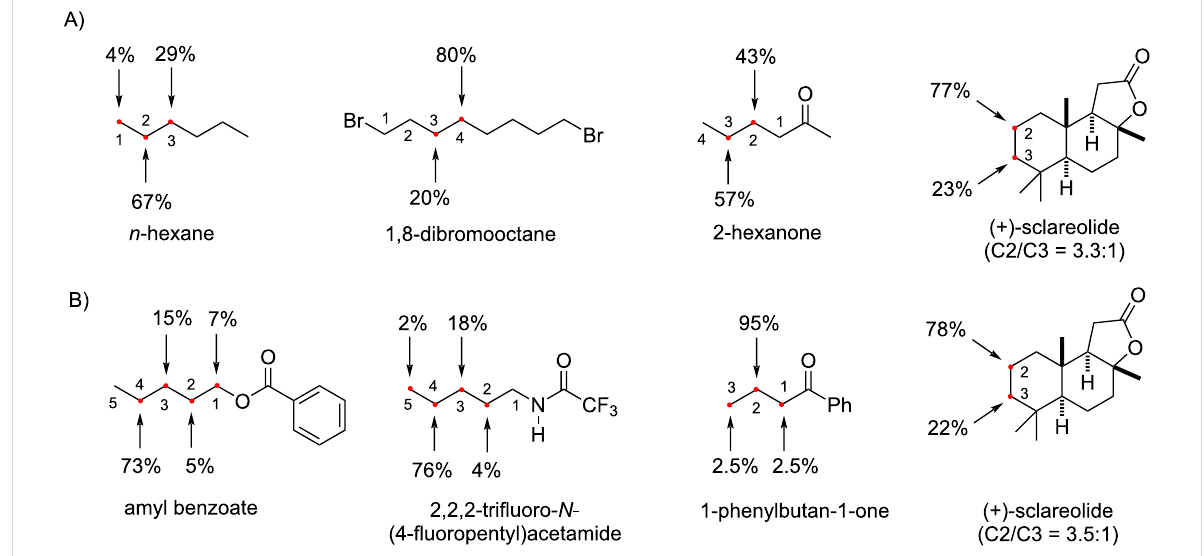
Figure 10: a) Site-selectivity of Chen’s acetophenone-photosensitized C–H fluorination reaction [201]. b) Site-selectivity of Tan’s AQN-photosensi- tized C–H fluorination reaction [198].